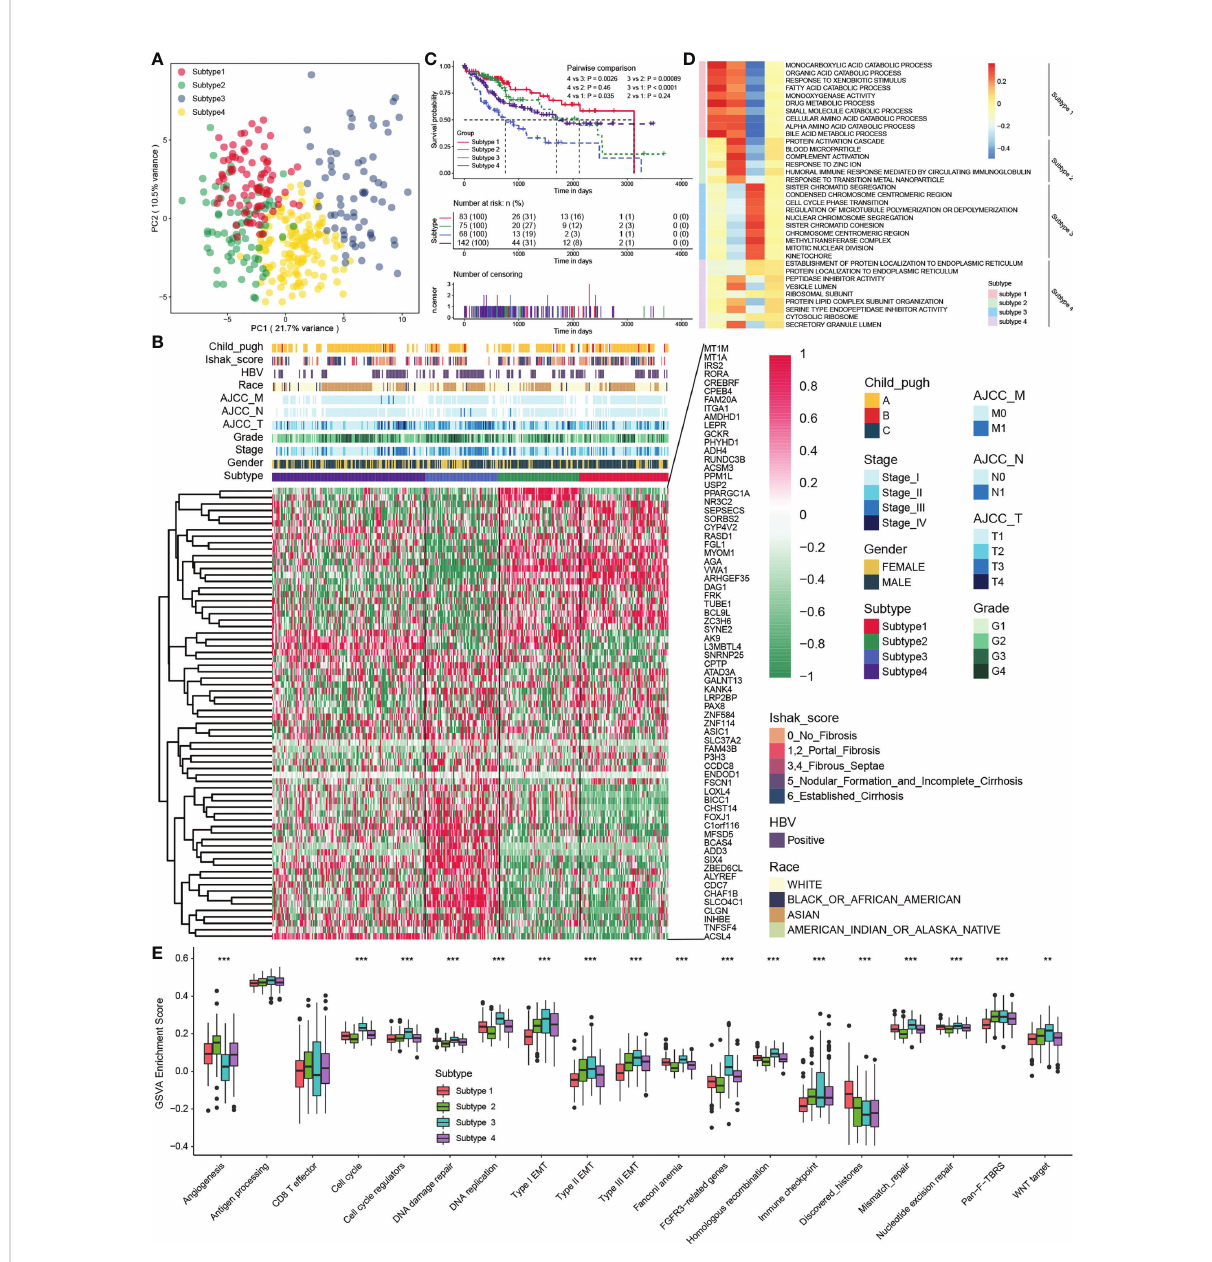
FIGURE 3 The four distinct MDH subtypes identi fi ed in HCC. (A) Principal component analysis for the transcriptome pro fi les in distinct MDH subtypes of the TCGA-LIHC cohort. (B) Unsupervised clustering of MDH gene signatures in the TCGA-LIHC cohort. (C) Survival analyses for distinct MDH subtypes of the TCGA-LIHC cohort. (D) GSVA enrichment analysis showing the activation states of biological pathways in distinct MDH subtypes of the TCGA-LIHC cohort. A heatmap was used to visualize these biological processes. (E) Differences in the expression of known signatures, including stromal activation-related signatures, tumour promotion-related signatures and immune activation-related signatures, in distinct MDH subtypes of the TCGA-LIHC cohort. The upper and lower ends of the boxes represent the interquartile range of values. The lines in the boxes represent the median value, and black dots show outliers. The asterisks represent the statistical p-value (**P< 0.01 and ***P<